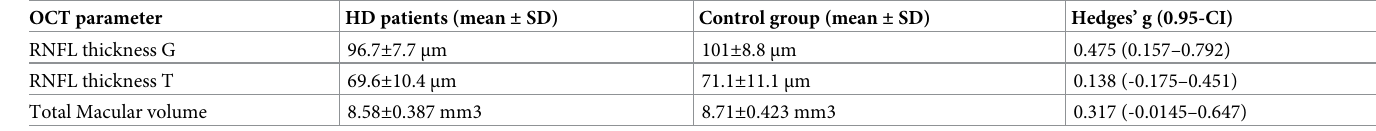
Table 2. RNFL-G thickness, RNFL-T thickness and macular volume parameters in Huntington’s disease patients and in healthy controls. OCT